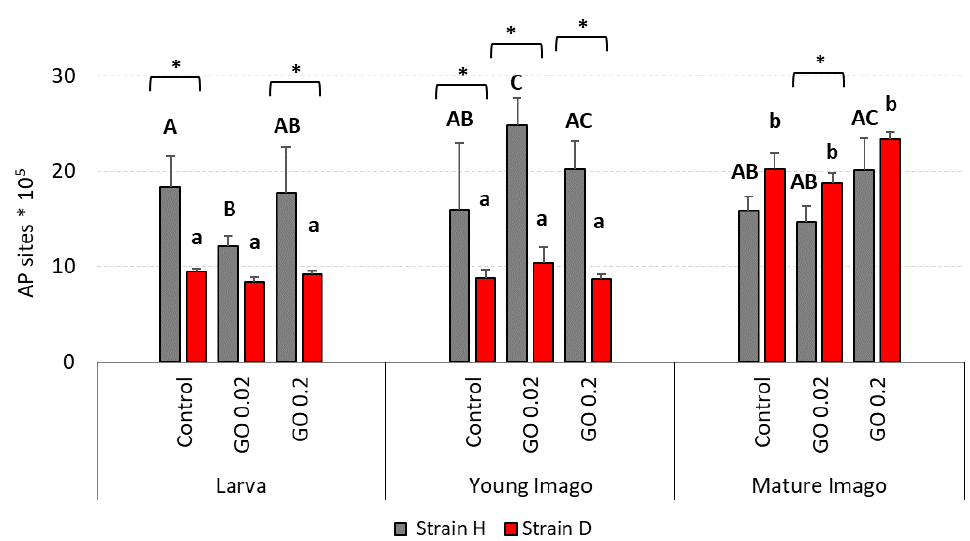
Figure 4. AP sites (apurinic/apyrimidinic sites) lesions in DNA in the gut cells of the wild (H) and long-living (D) strains of A. domesticus that had been chronically intoxicated with graphene oxide (GO). Measurements were conducted at larva (n = 4), young imago (n = 4) and mature imago stage (n = 4). Abbreviations: see Figure 1. Capital letters refer to strain H, while lowercase letters refer to strain D; asterisks indicate differences between the strains in each experimental group separately.